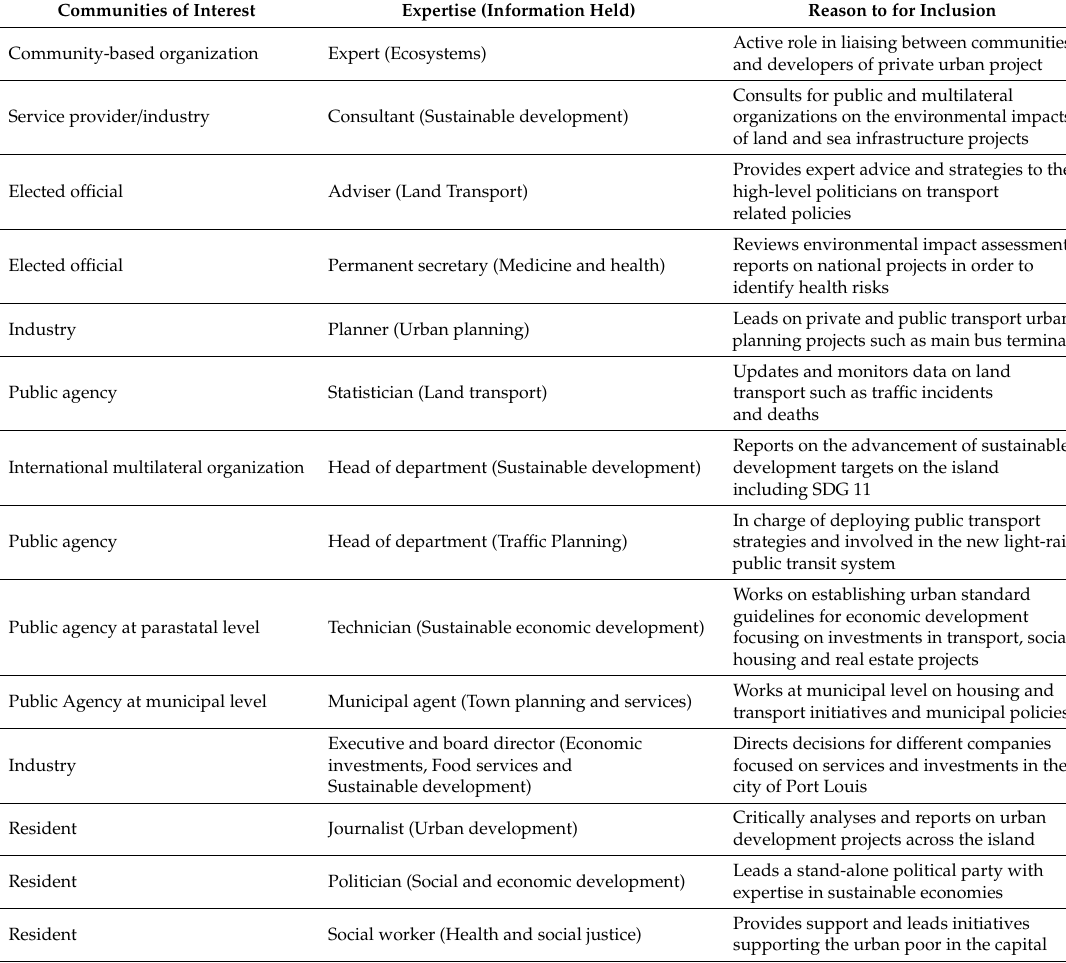
Table 1. Participant